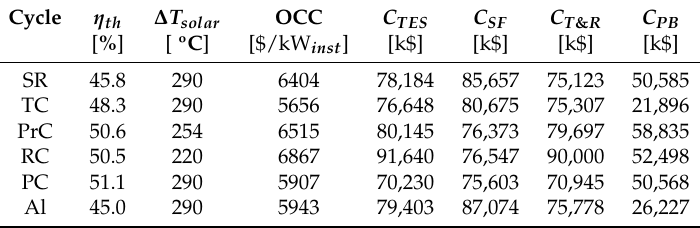
Table 3. Thermo-economic assessment of different cycle layouts. Adapted from [10]. Cycle η